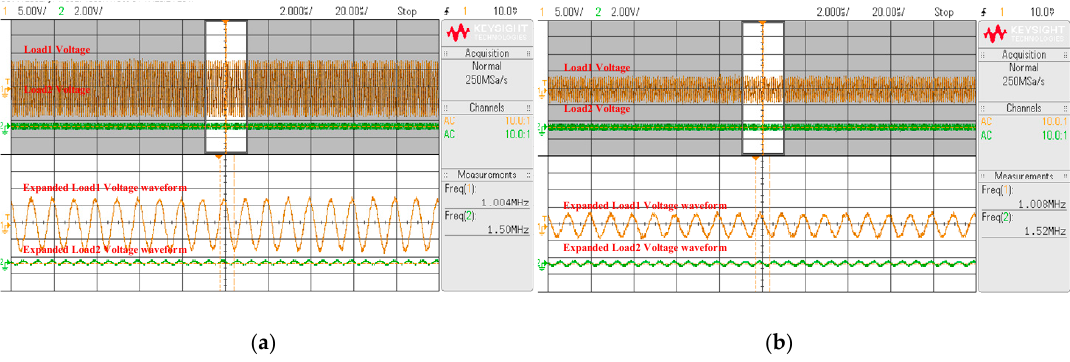
Figure 18. Measured load voltage of selective WPT system with load-1 variation ( a ) Rx1 at 3 c.m; ( b ) Rx1 at 7 c.m.